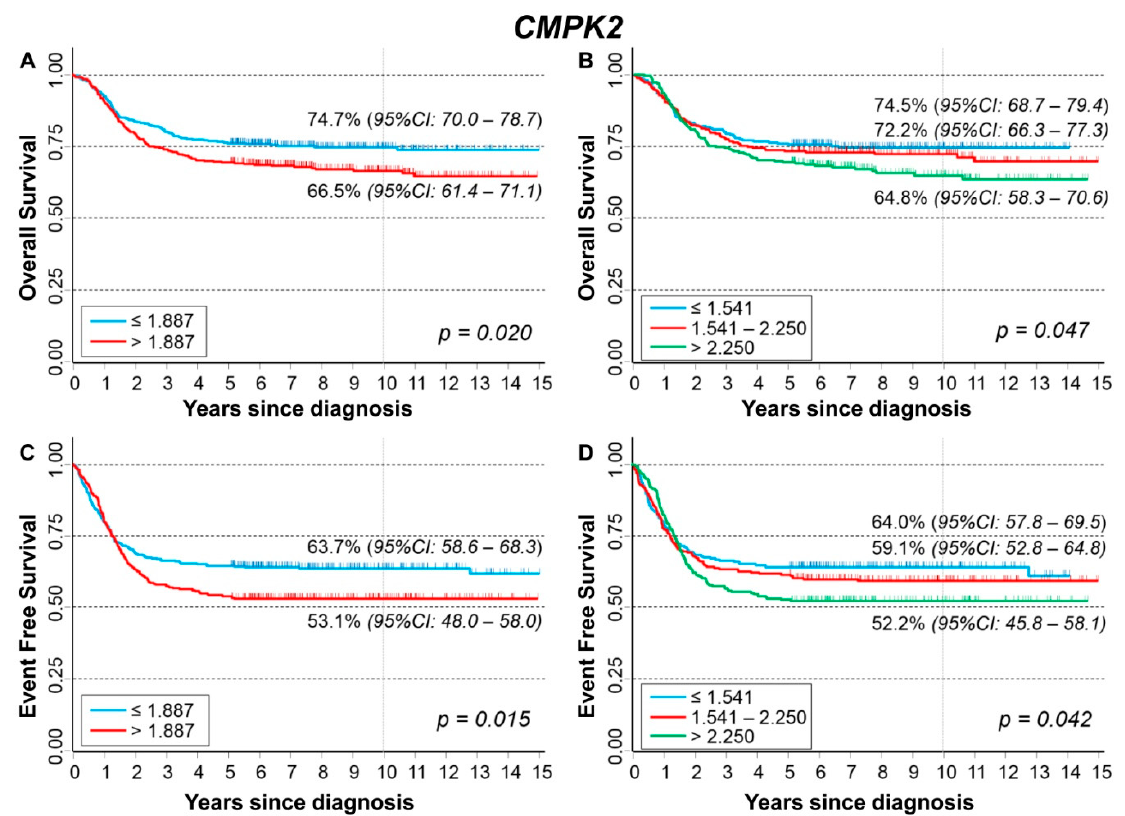
Figure 11. Patient Survival in relation to CMPK2 expression level. Overall Survival of 786 NB patients with ( A ) cut-off based on the median expression value or ( B ) on tertile expression values. Event Free Survival of 769 NB patients with ( C ) cut-off based on the median expression value or ( D ) on tertile expression values. Ten-year survival estimates are displayed. Table 10. Overall Survival of 786 NB patients in relation to CMPK2 expression levels evaluated by the Cox model.